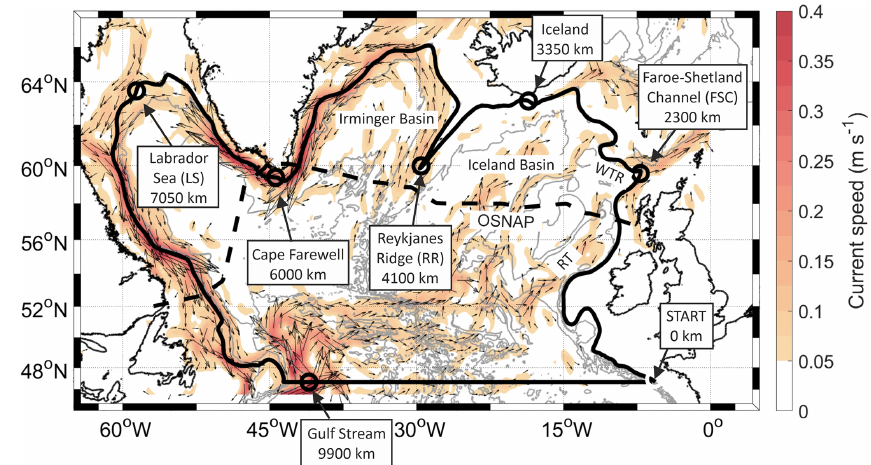
Figure 1. Smoothed 1000m bathymetry contour (solid black line) closed by transect across 47 ◦ N. Key locations around contour are labelled; these are used throughout this study. The dashed black line shows the OSNAP line. OSNAP-West denotes the portion of the line west of Greenland, and OSNAP-East denotes the portion of the line east of Greenland. RT is the Rockall Trough, and WTR is the Wyville Thomson Ridge. Mean magnitude and direction of surface currents (2000–2020) derived from AVISO data are shown by coloured contours and quiver arrows. Isobaths are overlaid at 1000m increments. Bathymetry contours from GEBCO bathymetry (http://www.gebco.net/, last access: 15 June 2020). GEBCO stands for the General Bathymetry Chart of the